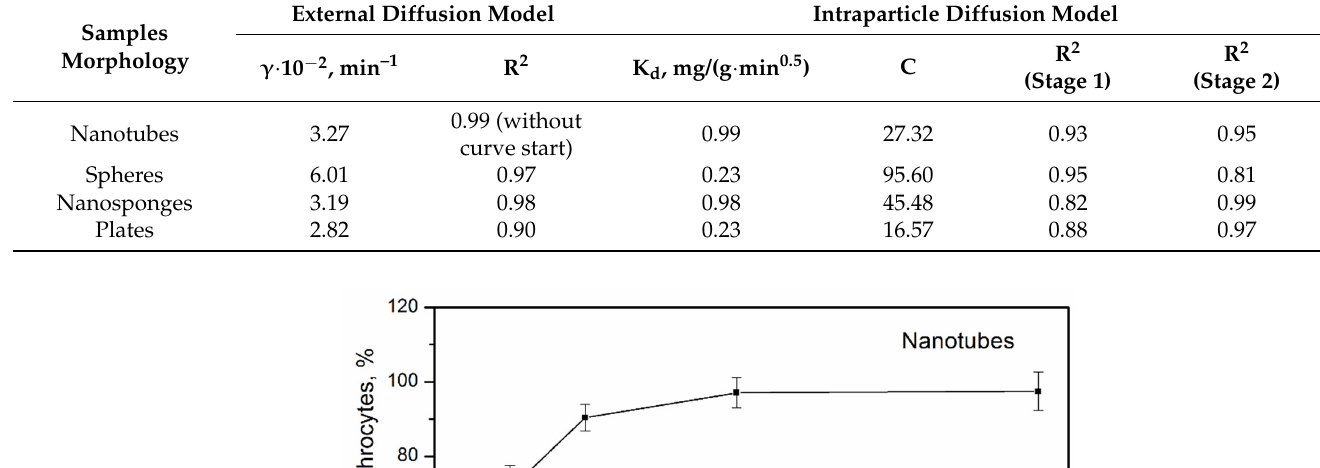
Figure 10. The hemolytic activity of the particles with different morphology.